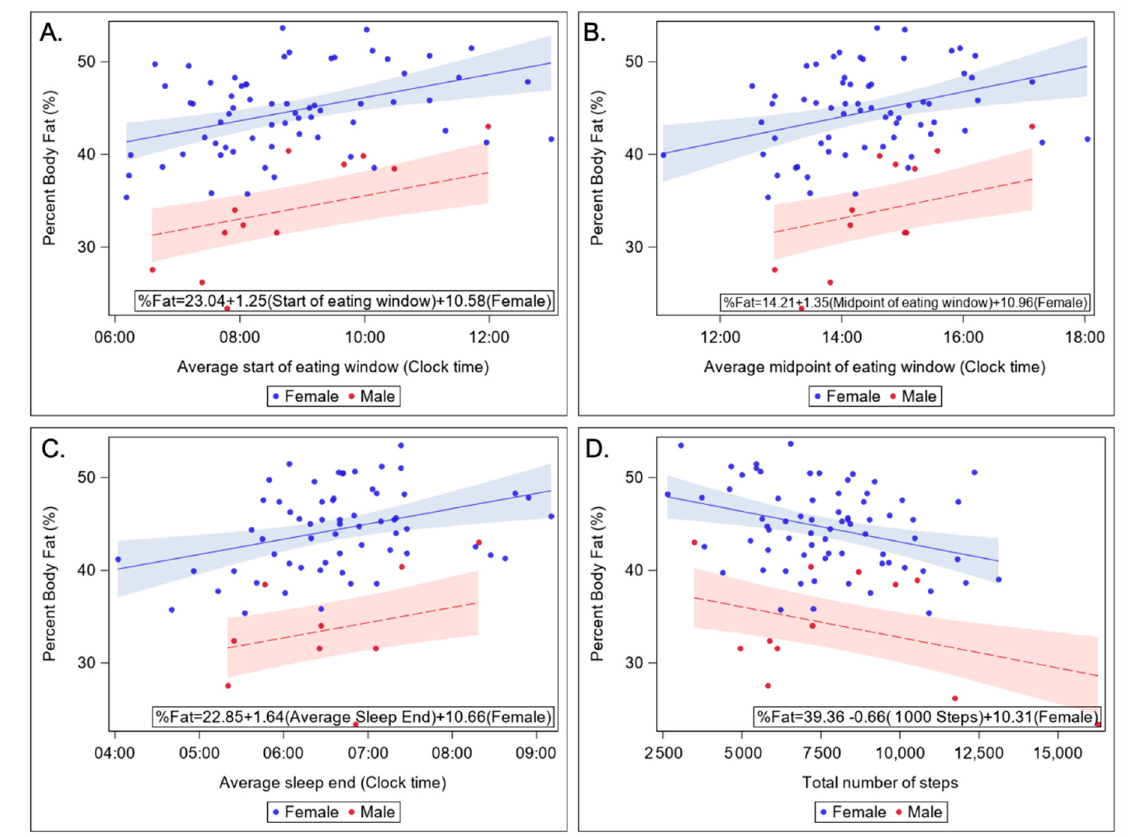
Figure 2. Scatter plots showing correlations between percent body fat and the start of the eating window ( A ), the mid-point of the eating window ( B ), sleep offset ( C ), and daily step counts per 1000 steps ( D ).